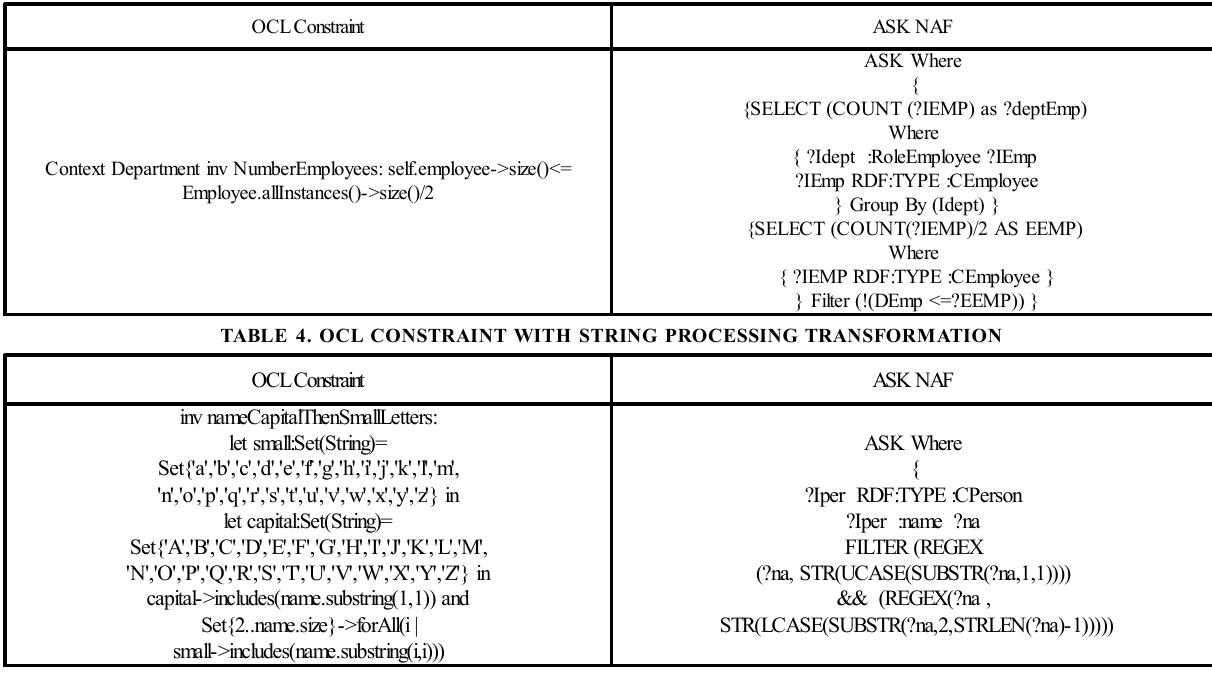
TABLE 4. OCL CONSTRAINT WITH STRING PROCESSING TRANSFORMATION